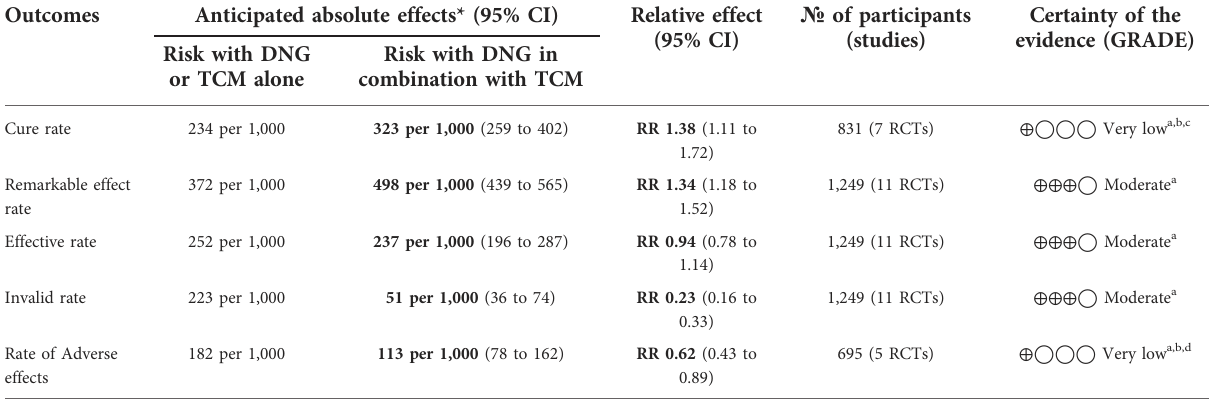
TABLE 4 GRADE rating of the quality of